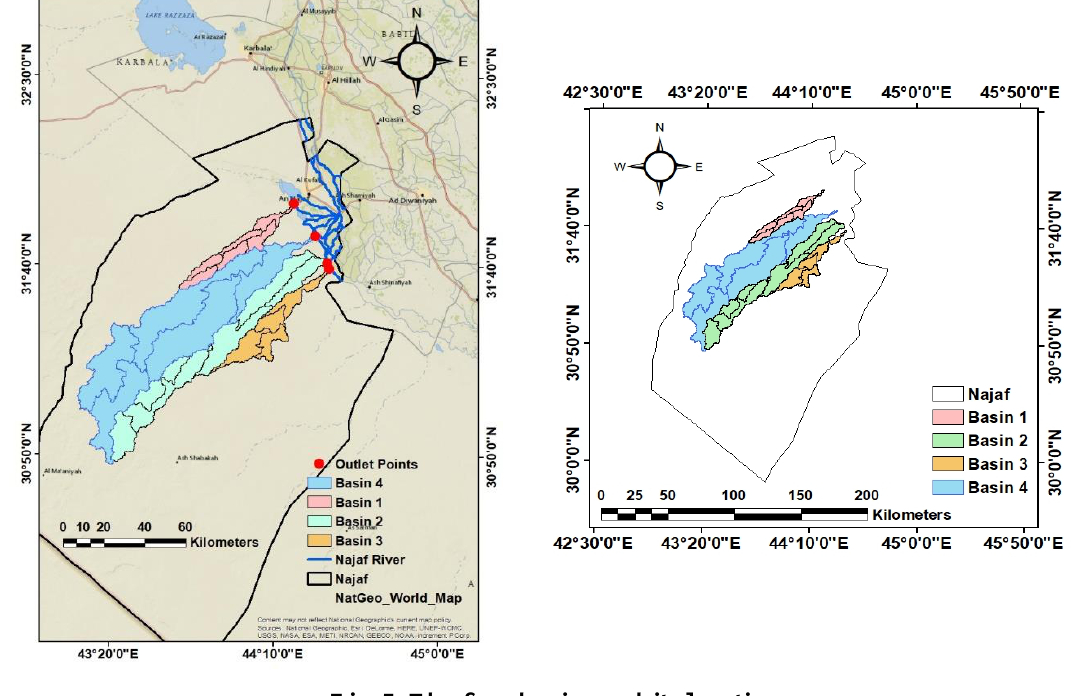
Fig. 5. The four basins and its locations.